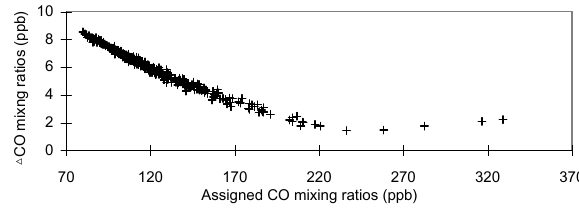
Fig. 4. Ambient CO: WMO2000 minus WLG working scale.